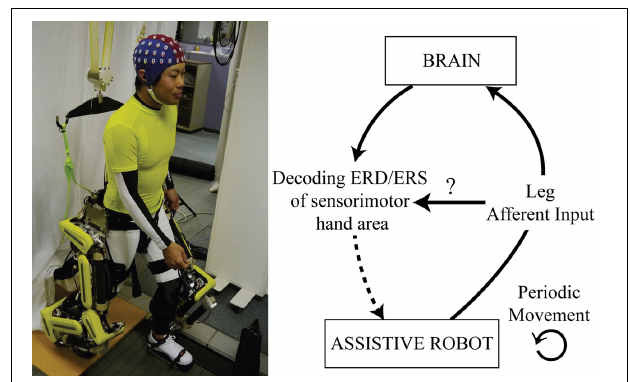
FIGURE 1 | Conceptual representation of the problem. Understanding how the leg afferent input, induced by a leg assistive robot, influences the decoding of the ERD/ERS of the sensorimotor hand area. The paper focuses on the concepts represented by the solid arrows of this